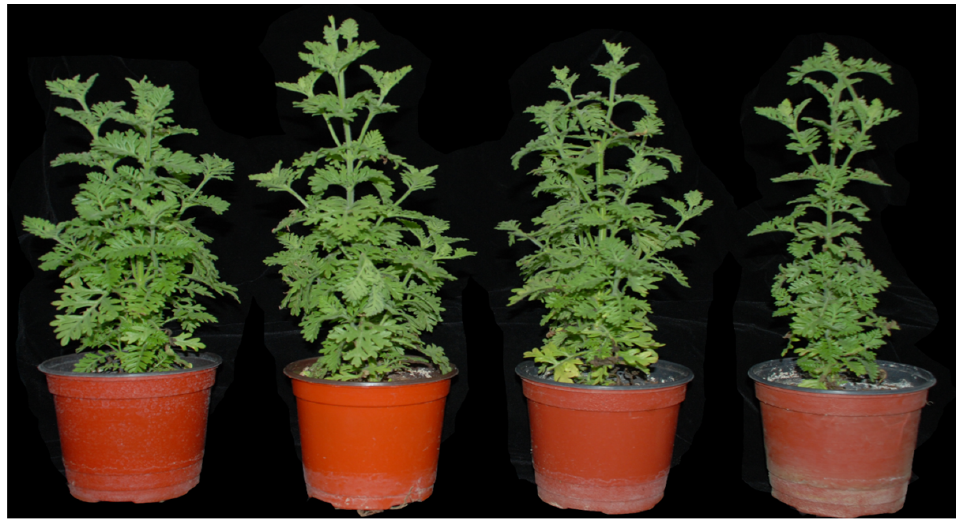
Figure 1. The phenotype of L. pubescens grown in a greenhouse. Terpenes are both the largest class of natural plant products and the most structurally diverse group in nature, the biosynthesis of which is initiated by the formation of two types of isoprene unit, isopentenyl diphosphate (IPP) and its isomer dimethylallyl diphos- phate (DMAPP), derived from the mevalonate (MVA) or 1-deoxy-d-xylulose5-phosphate (MEP) pathway (Figure 2). In the subsequent metabolic step, geranyl diphosphate syn- thase (GPPS) catalyzes the formation of geranyl diphosphate (GPP) (a C 10 precursor for monoterpene biosynthesis) via the condensation between IPP and DMAPP. The conden- sation between GPP and IPP is further catalyzed by farnesyl pyrophosphate synthetase (FPPS) to generate farnesyl pyrophosphate (FPP), known to be a C 15 precursor of sesquiter- penes. The formation of geranyl geranyl diphosphate, also known as the C 20 precursor of diterpenes, is catalyzed by geranyl geranyl diphosphate synthetase (GGPPS), which binds the resulting FPP with a further IPP. In the biosynthesis of triterpenes, there is a head-to-head dimerization between two FPP molecules, followed by an NADPH-requiring reductive rearrangement to form a squalene containing a C1-C1 ′ linkage between the two molecules, which is catalyzed by squalene synthase (SQS). Thereafter, squalene epoxidase (SQE) catalyzes the oxygenation of squalene to produce 2, 3-oxidosqualene, a common C 30 precursor of triterpenes. Biosynthesis of oleanolic and ursolic acids involves the cyclization of 2,3-oxidosqualene to generate α -amyrin and β -amyrin, catalyzed by α -amyrin